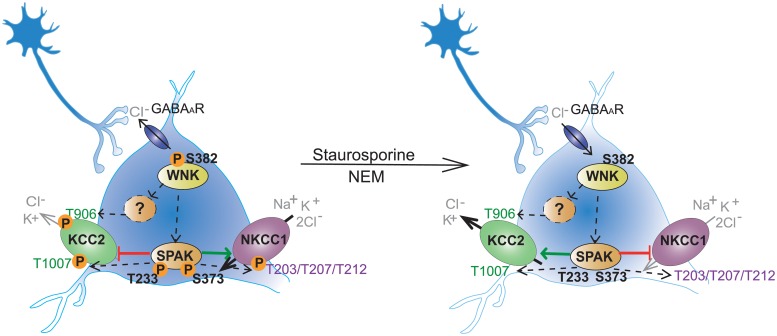
Staurosporine and NEM impair the WNK-SPAK/OSR1 mediated phosphorylation of KCC2 and NKCC1.In immature hippocampal neurons, the WNK mediated phosphorylation of SPAK/OSR1 directly phosphorylates T1007 of KCC2 and T203, T207 and T212 of NKCC1. WNKs also interact with a yet unknown kinase to phosphorylate Thr906 of KCC2. Phosphorylation of these residues decreases KCC2 and increases NKCC1 activity. Application of staurosporine or NEM decreases phosphorylation of S382 of WNK1 and T233 and S373 of SPAK. This likely results in reduction of phosphorylation of T906 and T1007 in KCC2 and of T203, T207 and T212 in NKCC1. Dephosphorylation of these residues increases KCC2 activity and decreases NKCC1 activity. The figure is modified from Moore et al. [39].